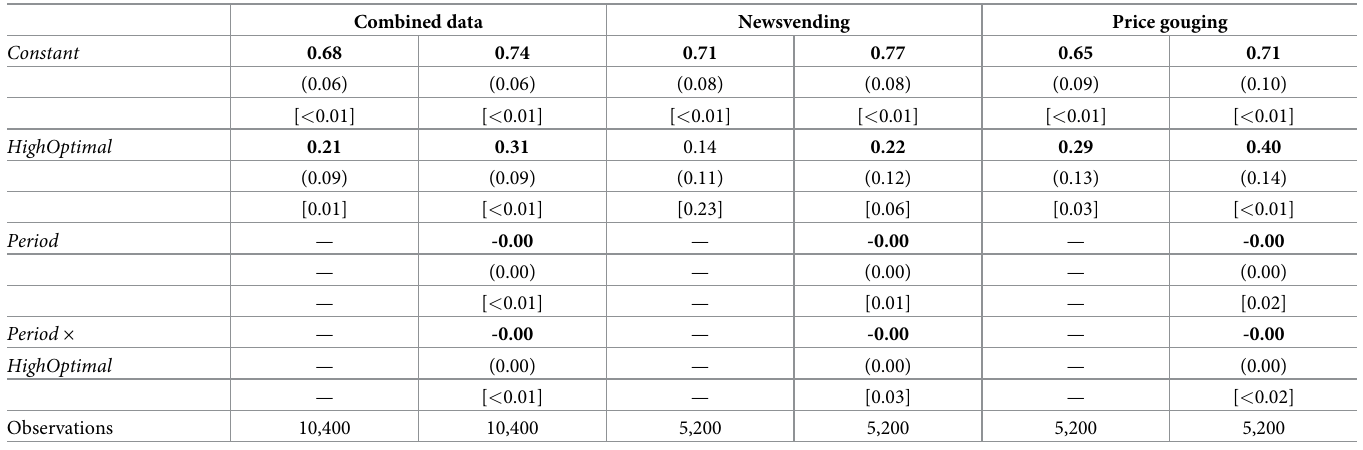
Table 5. Analysis of asymmetric pull-to-center